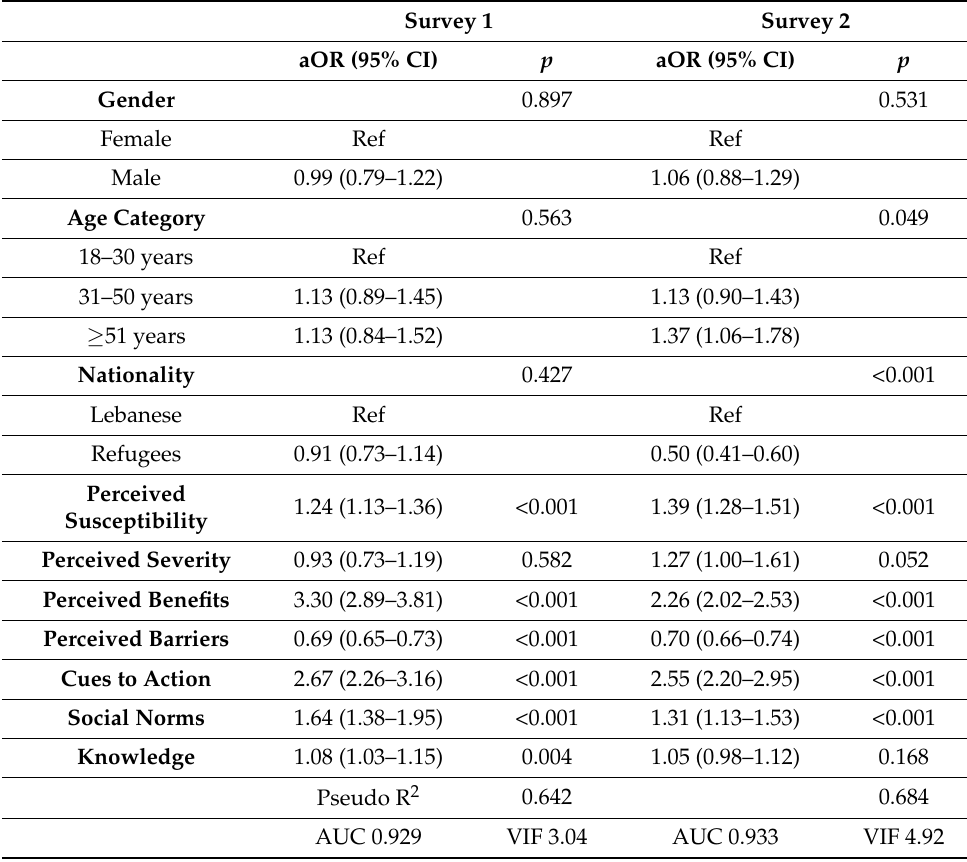
Table 5. Intention to receive vaccine by HBM domains, social norms, and vaccine knowledge in multivariable